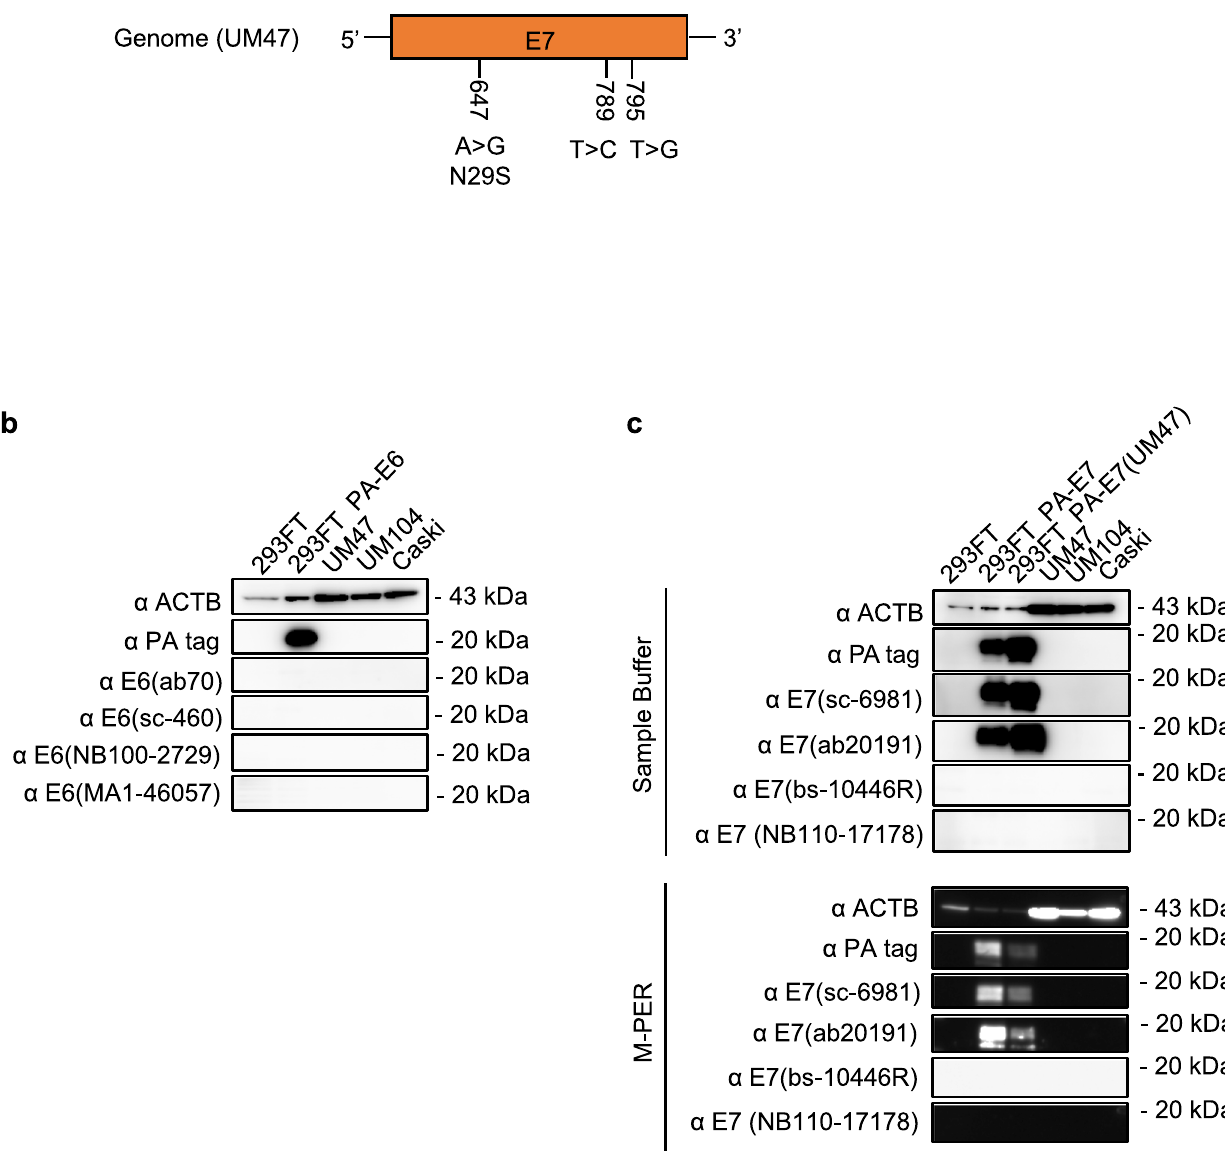
proteins were extracted using the sample buffer or with